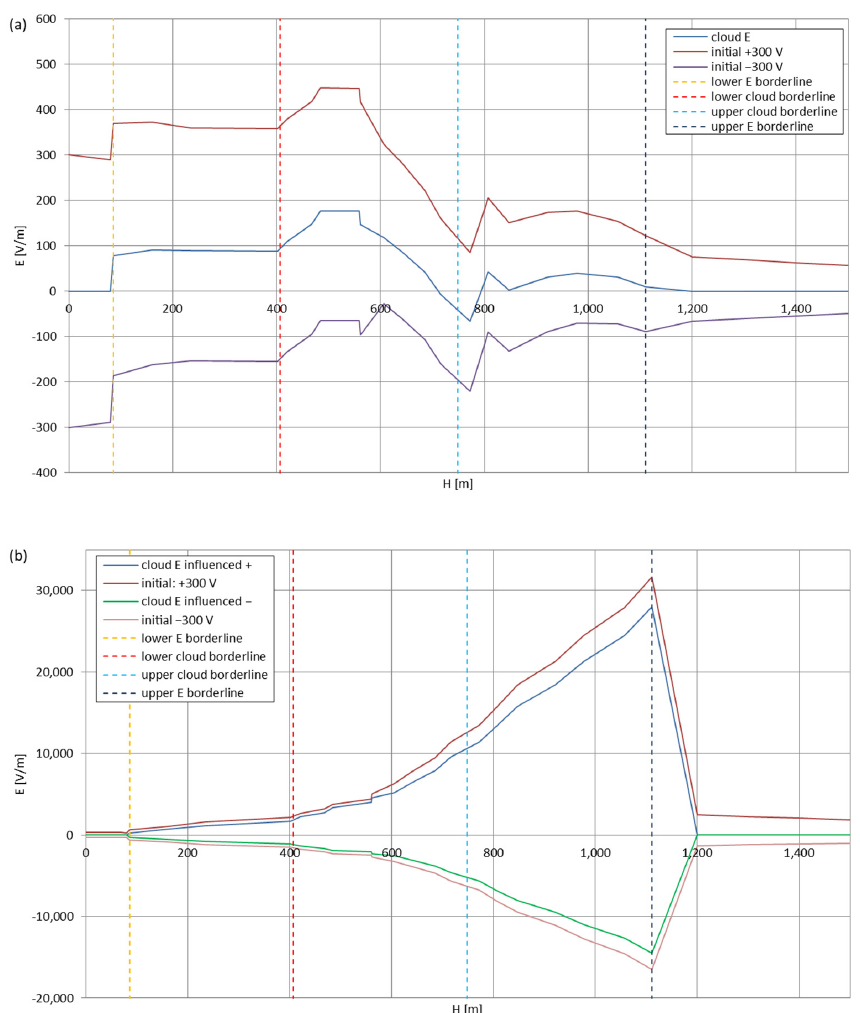
Figure 5. Maximum electric field strengths around the wire antenna passing through Stratocumulus cloud positively polarized: ( a ) ‘static’ case and ( b ) ‘dynamic’ case.